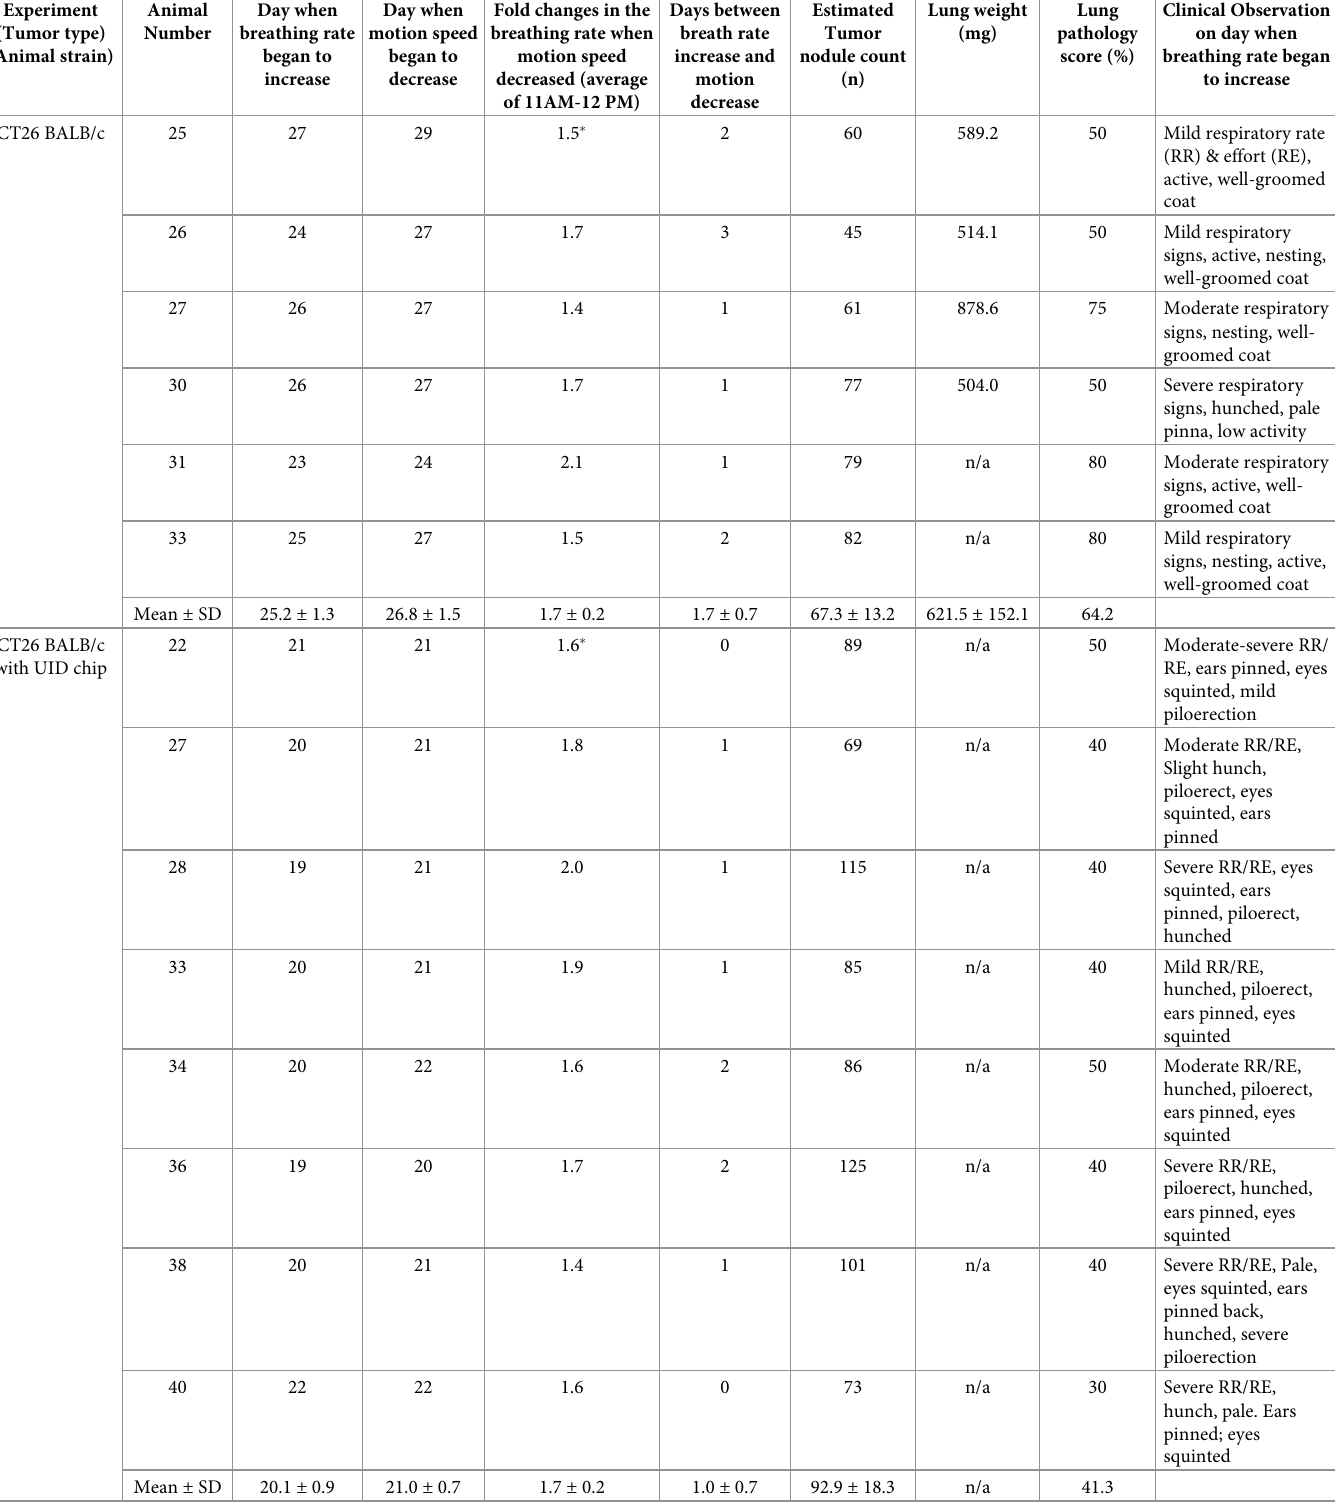
Table 1. Time courses of breathing rate and motion speed in animals with overt lung metastasis. Experiment (Tumor